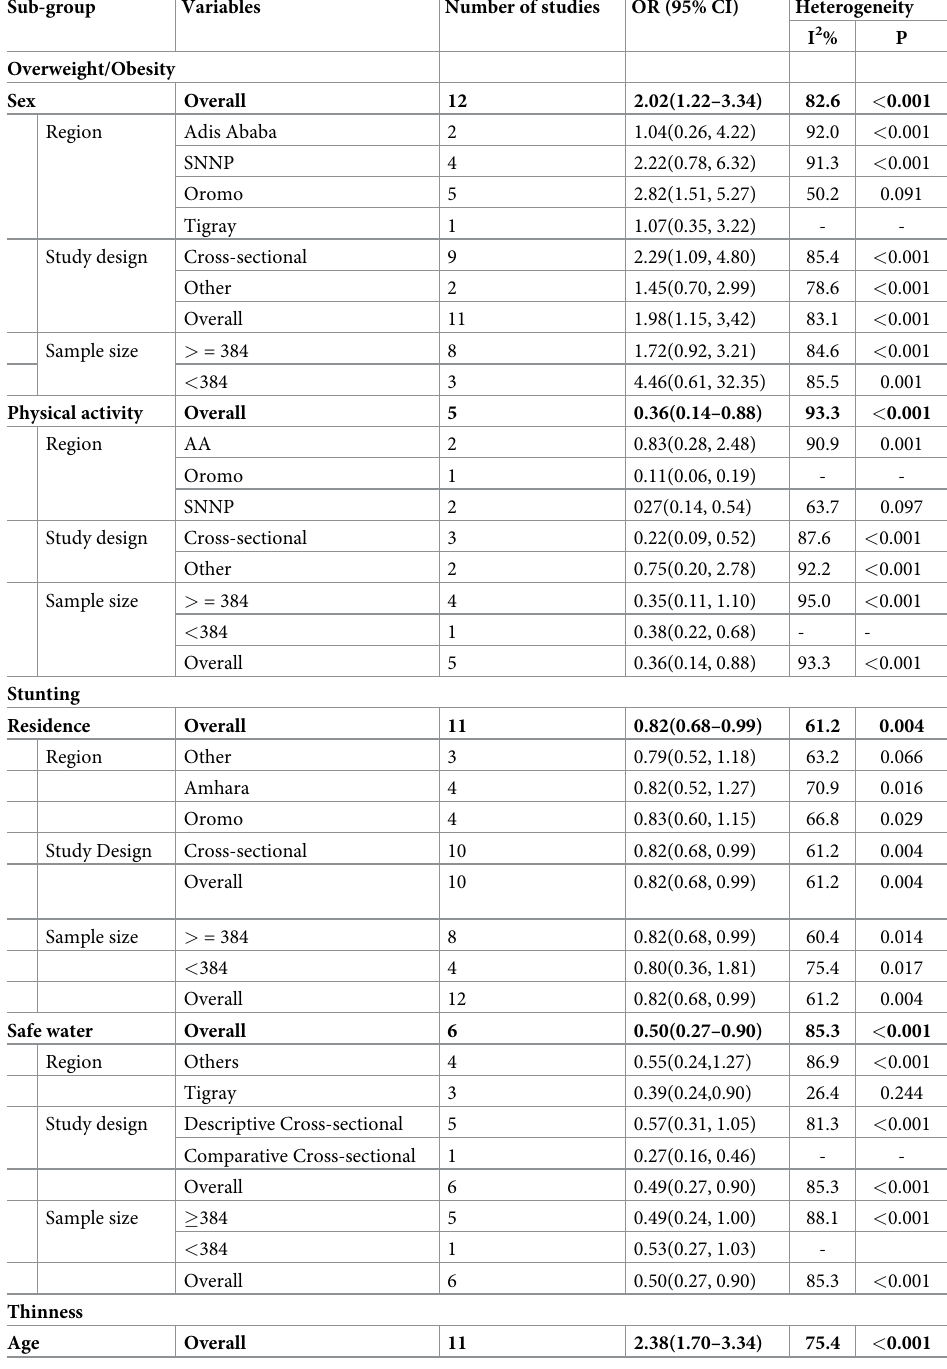
Table 6. Subgroup analysis of factors associated with adolescent malnutrition in